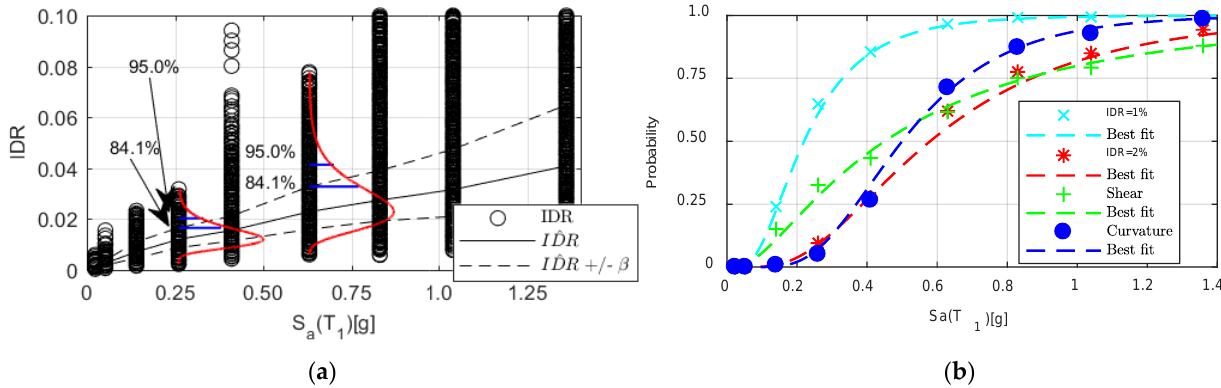
Figure 9 . Multi-stripe analysis results for the 12-story case study building; ( a ) inter-story drift ratio demands obtained at each intensity level; ( b ) probability of limit state exceedance and associated fragility curve. Table 4. Median intensity and dispersion for different failure limit states obtained via rigorous MSA and Mont Carlo simulations.